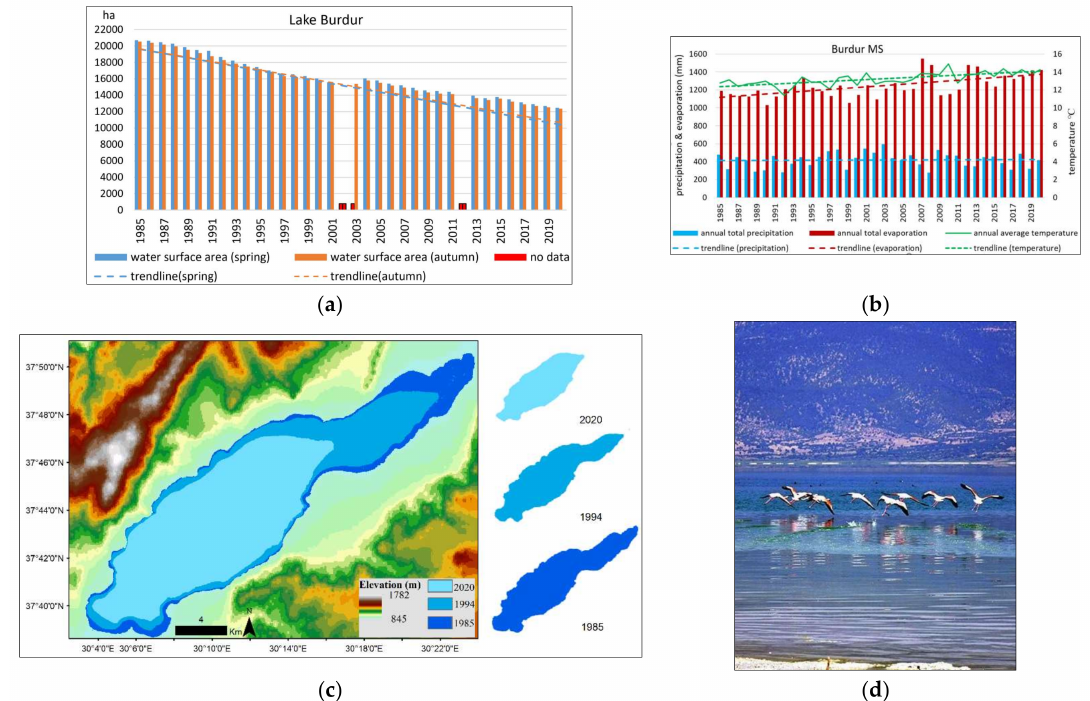
Figure 7. Lake Burdur: ( a ) 1985–2020 annual (spring and autumn) surface water areas; ( b ) representative meteorological station data (precipitation, evaporation, and temperature); ( c ) water surface a rea change in spring (NDWI); ( d ) view of the lake